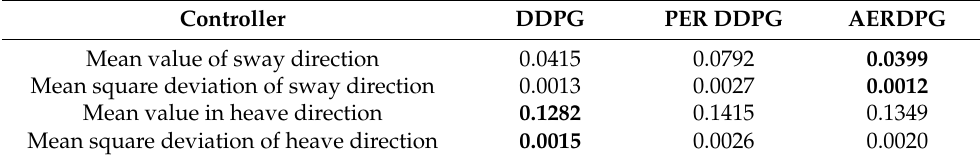
Table 4. The performance indicators for the three controllers (Bold represents the optimal